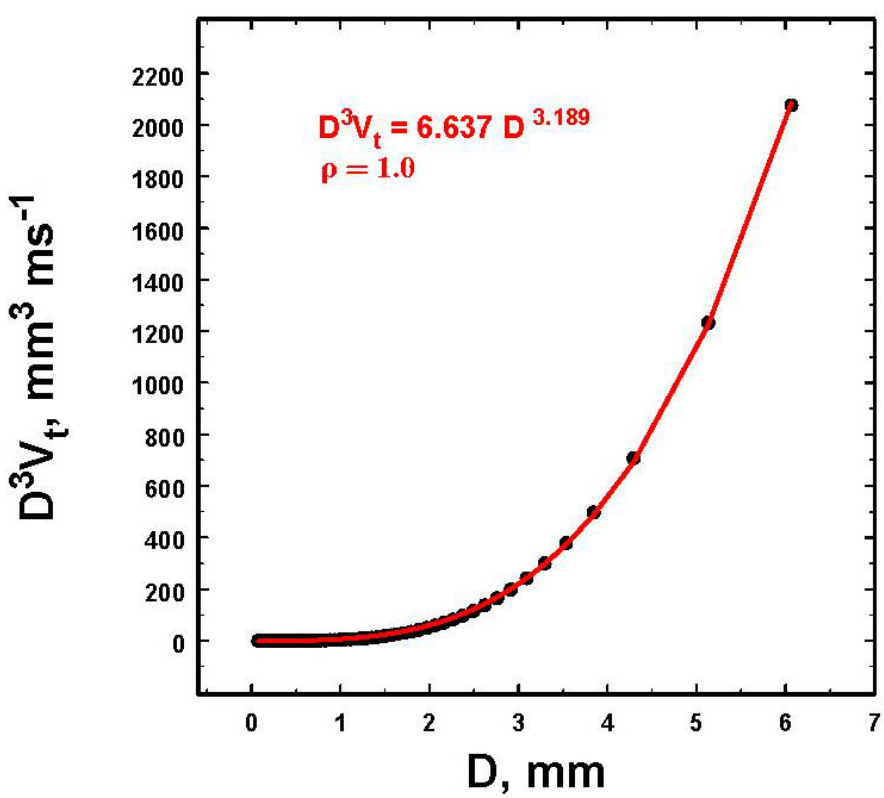
Figure 2. The volume flux of raindrops falling at terminal velocity, V t , as a function of spherical drop size.